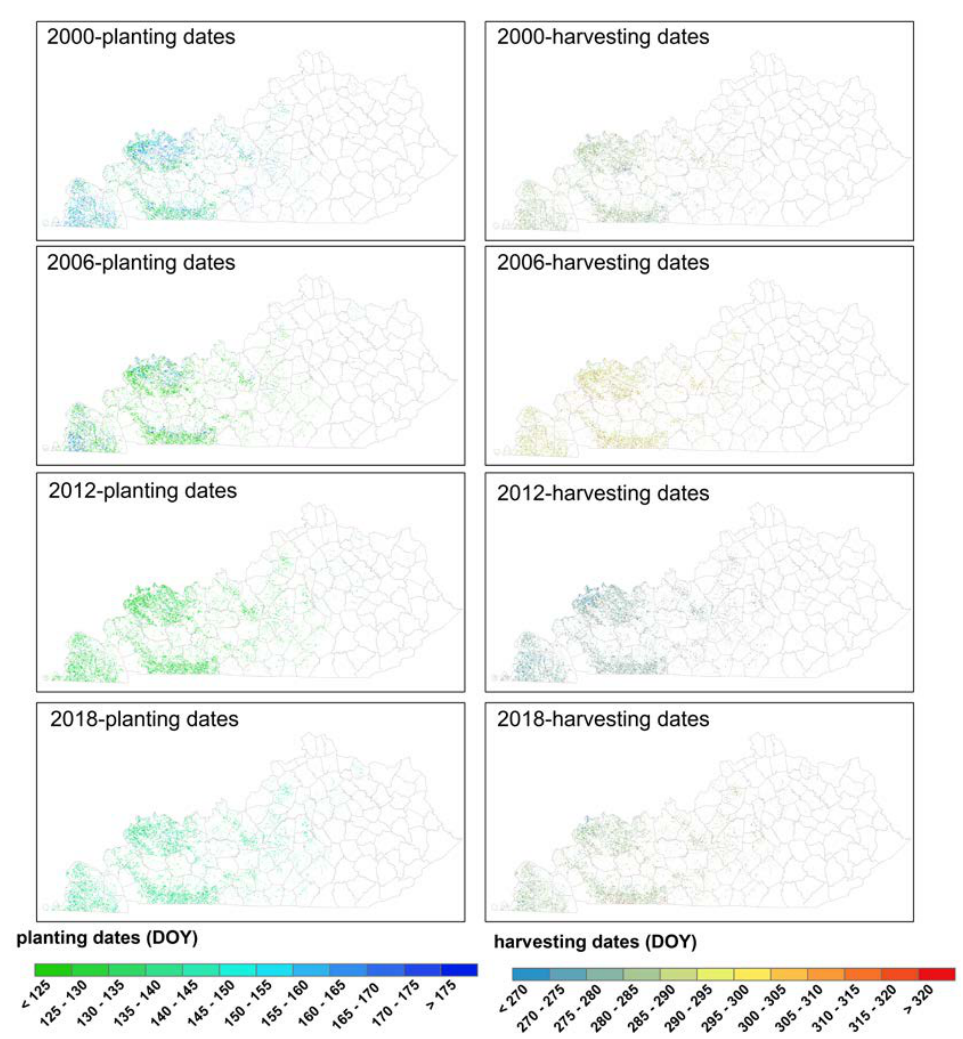
Figure 5. Spatial variations of corn phenological stages in Kentucky.